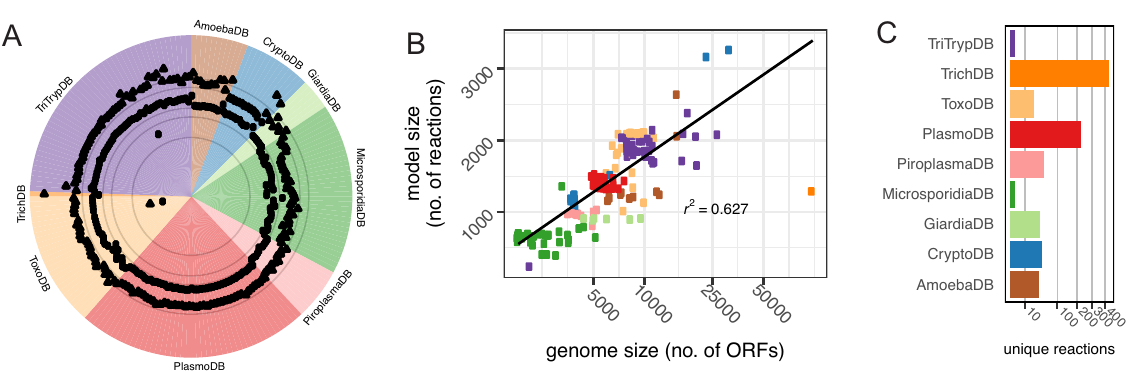
Fig 3. Reconstructions for all eukaryotic organisms with published genomes. (A): Model summary. Genome size is measured here by the number of amino acid sequences encoded by the genome ( triangle ) and model size is measured by the number of reactions present in the network ( square points ). Grey rings highlight 100, 500, 1000, 5000, and 10,000 ORFs moving from the center outwards. Genomes are grouped by database, a rough phylogenetic grouping (see Fig 1 ). Note: T . gondii RH is excluded from all future analyses given only a subset of the genome is available from EuPathDB. (B): Model size is correlated with genome size. Larger genomes tend to generate larger models. Line is fit to a linear regression with R2 noted (p-value < 0.001); the standard error is not shown. Points are color-coded by database. (C): Unique reactions by database. Number of unique metabolic reactions per database. Unique reactions are defined here as reactions found in every reconstruction within a database grouping and in no other reconstructions outside of that database grouping. Reactions found in different cellular compartments are considered distinct reactions.